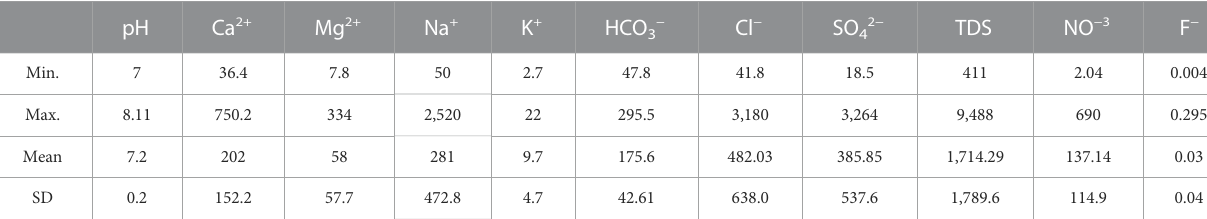
TABLE 3 Physico-chemical parameter statistics for groundwater samples.